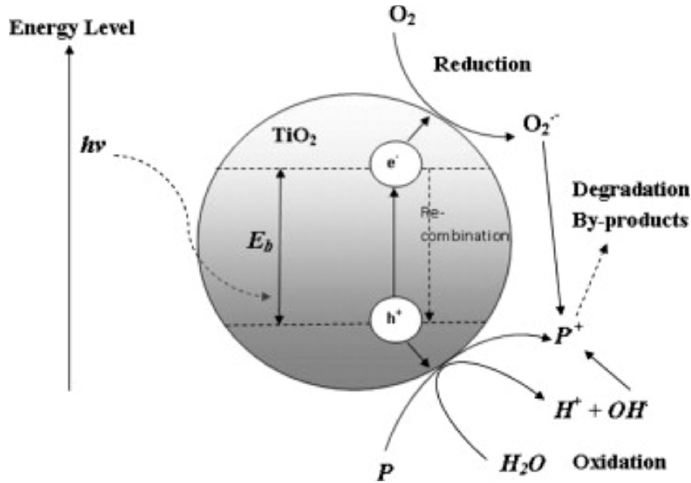
Figure 2. Mechanism of the electron-hole pair formation and the pollutant (P) degradation. Reproduced from [92], with permission from Elsevier, 2010.